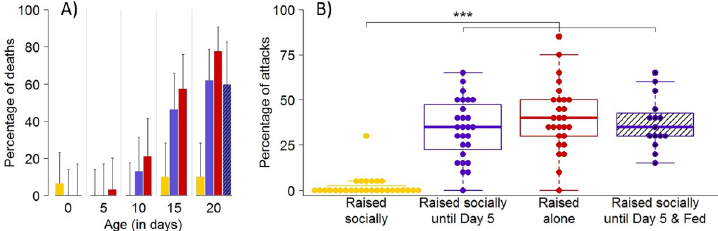
Fig 4. Social isolation triggers cannibalism and aggressiveness. (A) Proportion ( ± 95% CI) of deaths in pairs of spiderlings as a function of time (days) since emergence. Unfed spiderlings were maintained in groups (yellow bars), in groups for five days before being placed in isolation (blue bars), or alone (red bars) before their introduction to test arenas. The hatched bar gives the rate of cannibalism in pairs of 20-day-old spiderlings raised socially for five days before being placed alone but that were fed three times. Sample size ranged between 24 and 30 replicates for each condition. For statistical analysis, see S4 Table. (B) Boxplots of the proportions of aggressive encounters (bite attempt, effective bite or chasing) between 20-day-old spiderlings raised in groups and unfed (yellow), raised in groups for five days before being placed in isolation (unfed: blue, fed: blue hatched), or maintained alone and unfed (red). A dot gives the proportion of aggressive encounters for each pair. Horizontal line in each box represents the median, and the lower and upper hinges indicate the first and third quartiles. Lower and higher whiskers extend to the most extreme values within 1.5 interquartile ranges from the first and third quartiles respectively. Significant difference is indicated by ��� (Dunn’s test, P < 0.001). Relevant data values are included in S1 Data.